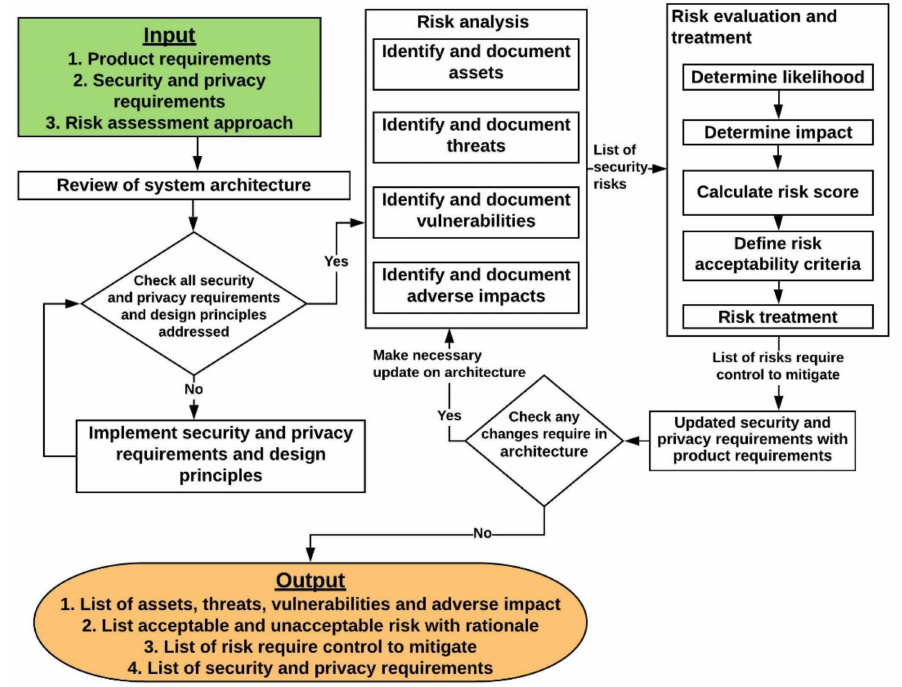
Figure 9. Security and privacy risk assessment steps in the system architecture